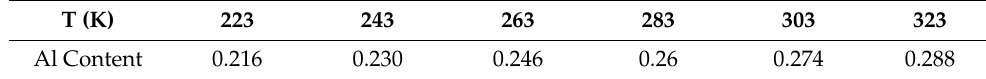
Figure 1. Simulated carrier confinement efficiency model: ( a ) the carrier concentration distribution with energy level for In 0.14 Al 0.14 Ga 0.72 As/Al 0.25 Ga 0.75 As quantum well at 223 K ( b ) carrier confine- ment efficiency vs. Al content of the quantum barrier at different temperatures. Table 3. Al content of quantum barrier that satisfies η con = 96%.